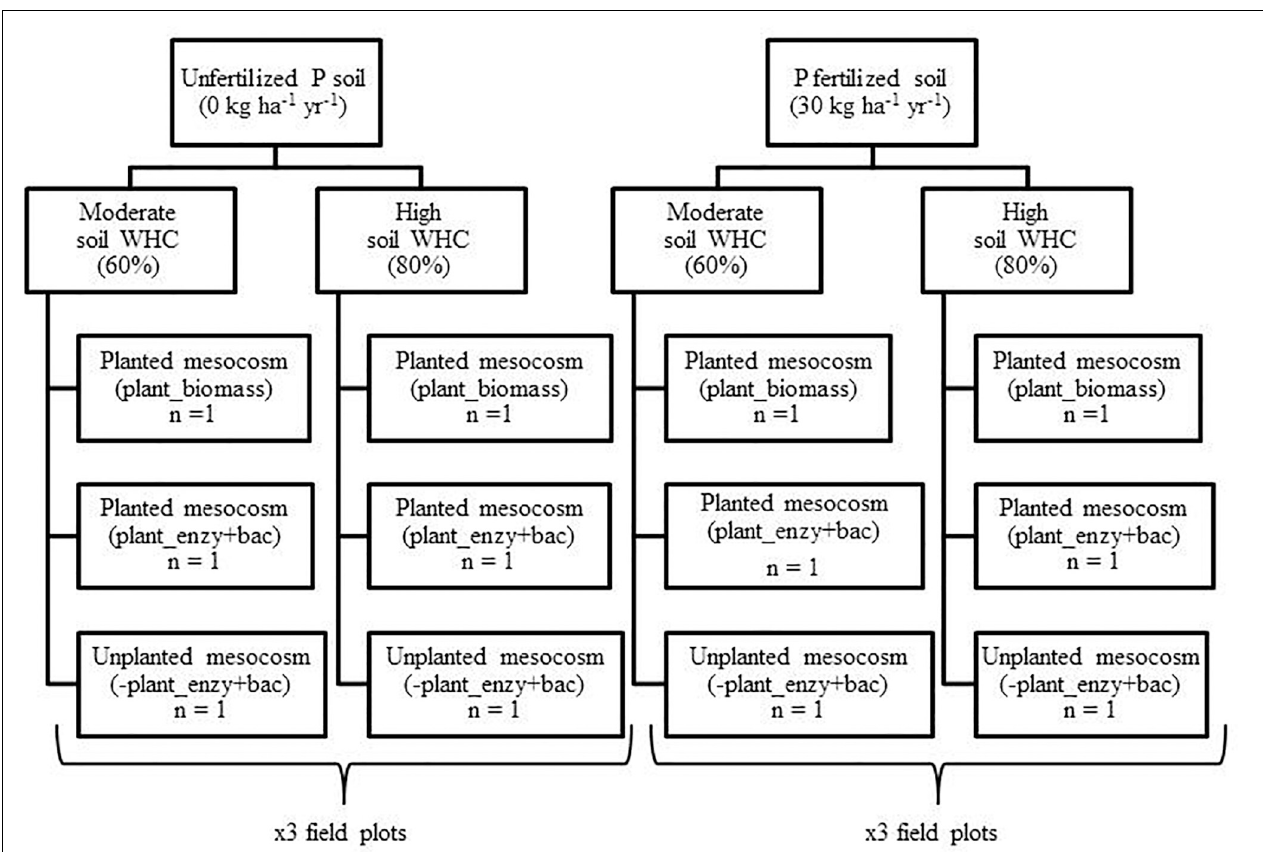
FIGURE 1 | Design of the mesocosm growth chamber experiment. Field soil was sampled from a long-term inorganic phosphorus (P) field trial (44 years), from unfertilized (P0) ( n = 3) and fertilized (P30) (30 kg ha − 1 y − 1 ) ( n = 3) field plots. Soil water holding capacity (WHC) was then manipulated to either 60% or 80% and was maintained. Mesocosms were either sown with an individual seed of spring wheat (T. aestivum), Trappe variety (Goldcrop Ltd., Co. Cork, Ireland), or remained unplanted, serving as negative plant controls. The experiment ran for four months within a growth